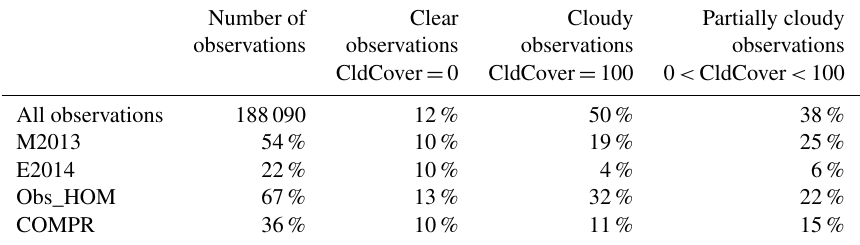
Table 3. Overview table of statistics obtained with the different homogeneity criteria: number of observations retained, percentage of cloudy observations (cloud cover of 100), percentage of fully clear observations (cloud cover of 0). Percentages are given with respect to all the